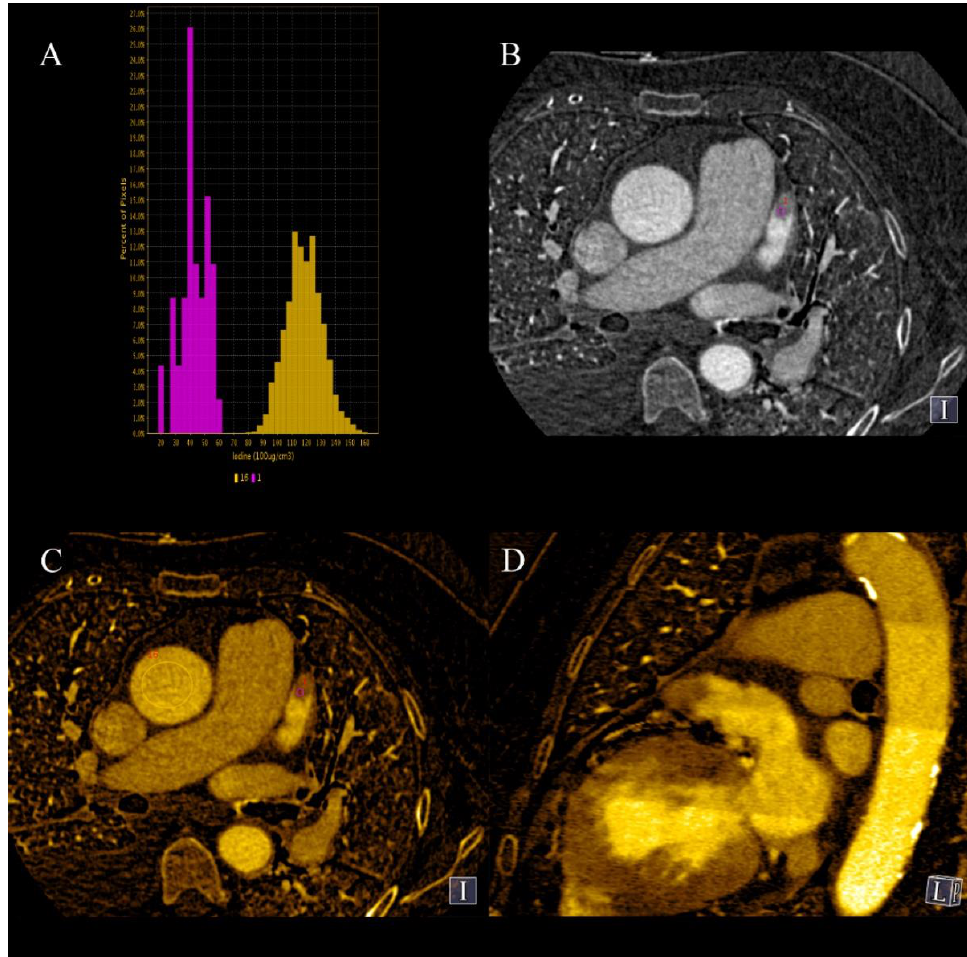
Figure 7. ( A – D ). Case of patient with chronic atrial fibrillation after 3 unsuccessful ablations, currently admitted due to chest pain. Coronary CTA was performed to roll out coronary artery stenosis. Differentiating thrombus and filling defect of LAA using iodine concentration is much more specific of iodine concentration in ROIs; ( B )—map iodine(water) shows lower concentration of iodine in